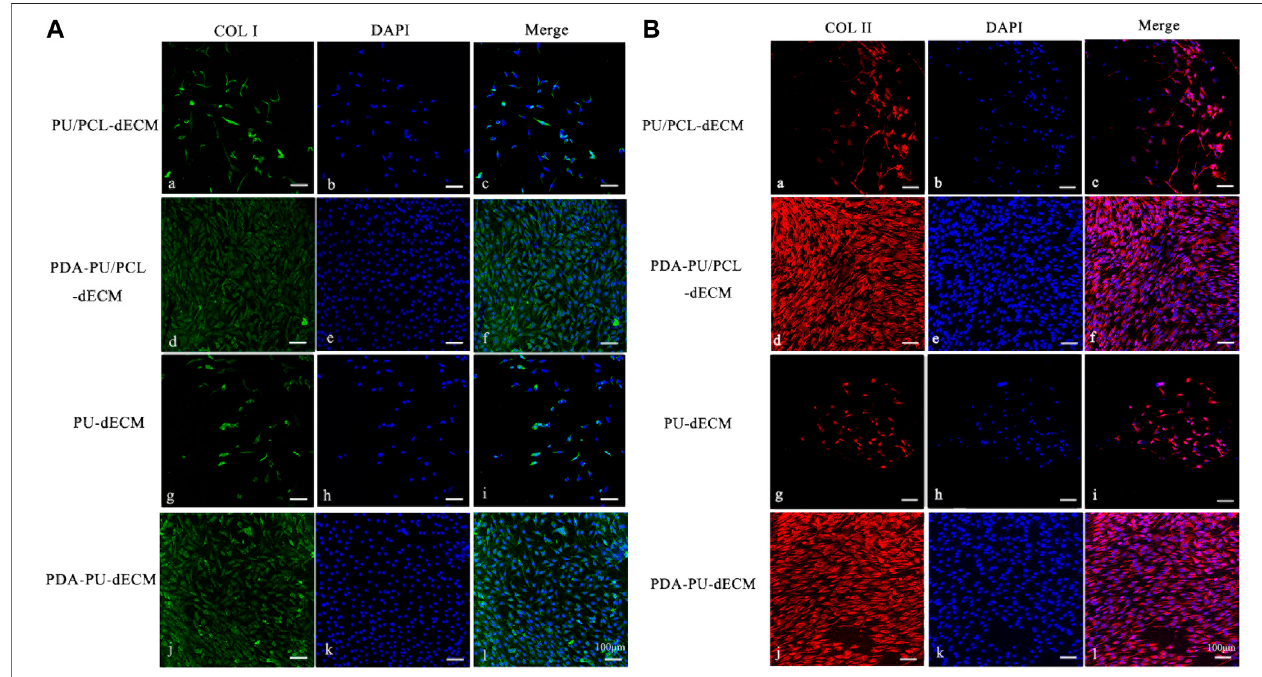
FIGURE 6 | Immuno fl uorescence staining images of the scaffolds. (A) COL I and (B) COL II.